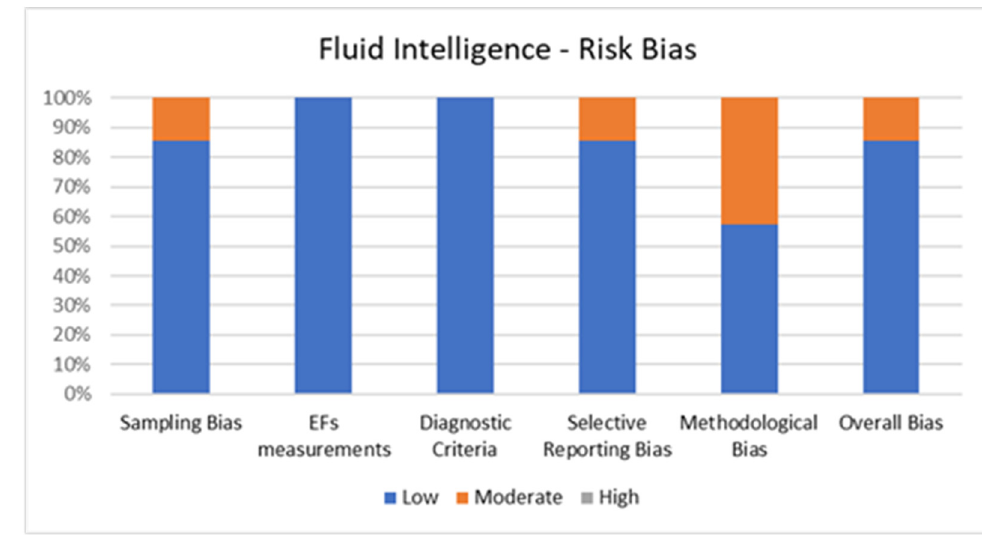
Figure 6. Risk of Bias for Fluid Intelligence.